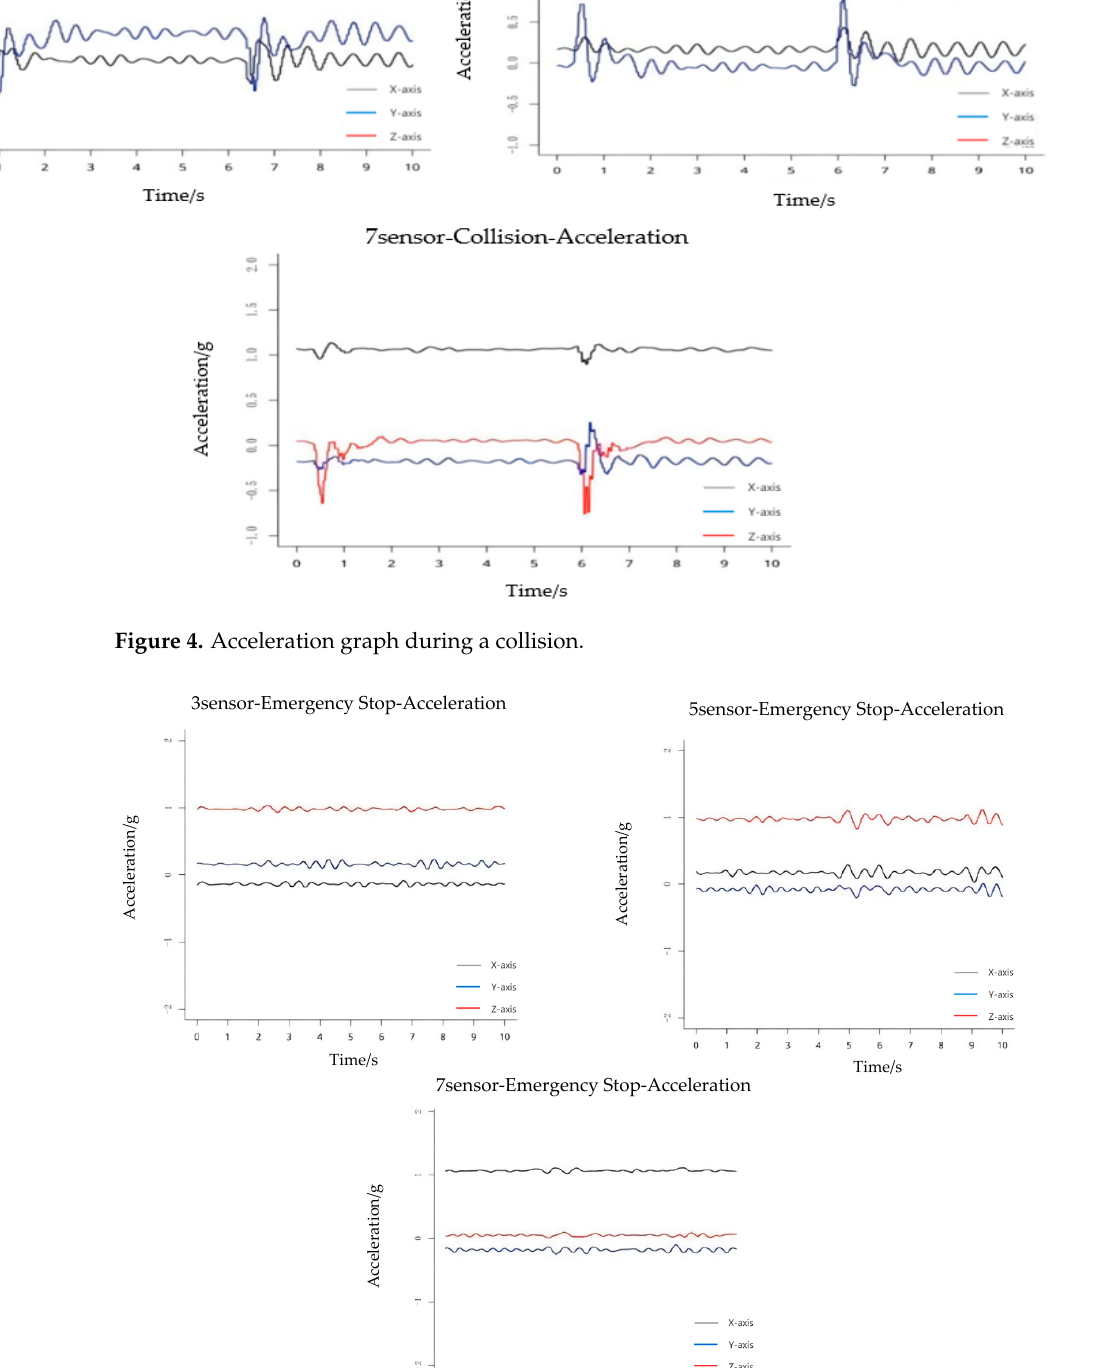
Figure 6. Angular velocity graph at the sudden stop.